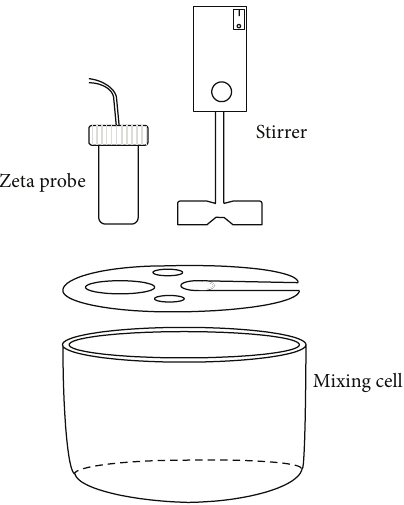
Figure1:Schematicdiagramoftheapparatususedinthezetapoten- tial technique to measure wettability.